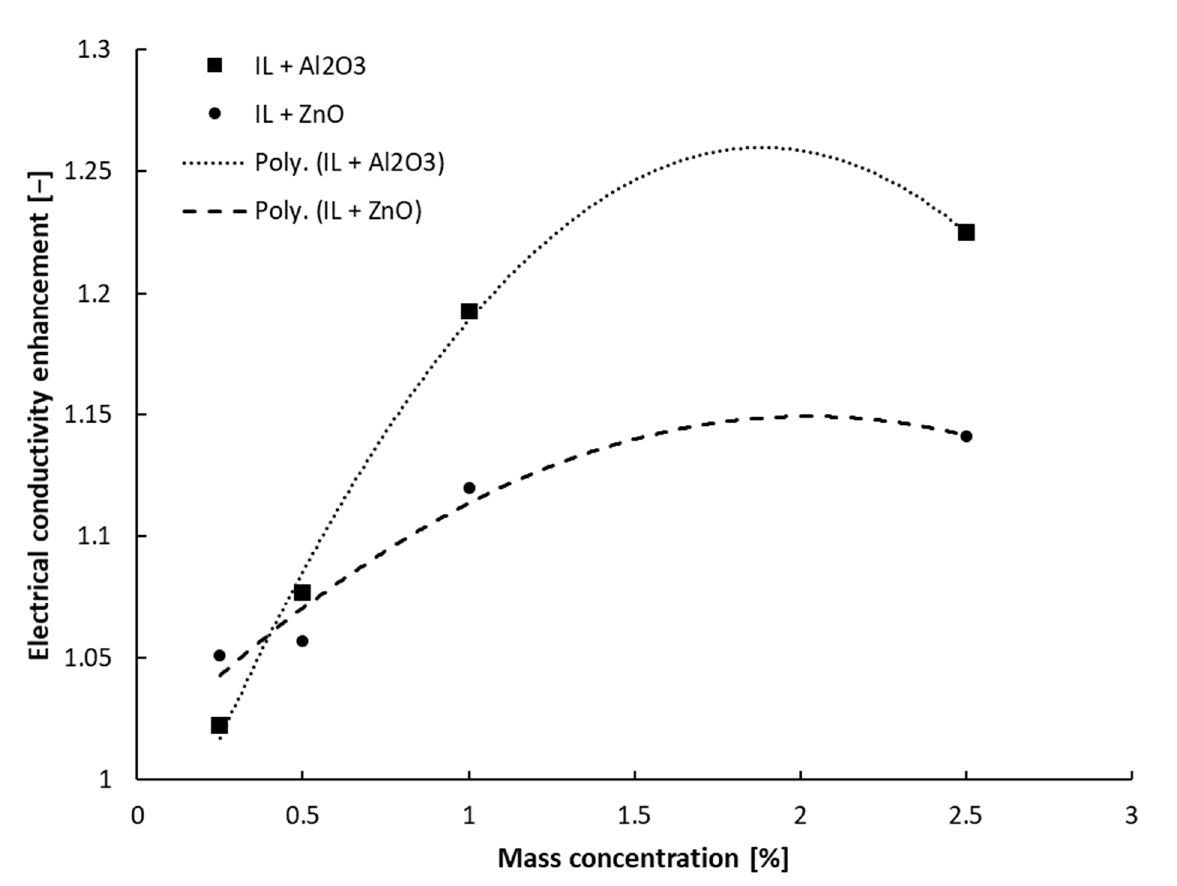
Figure 2. Electrical conductivity enhancement data of oxide samples at ambient temperature.